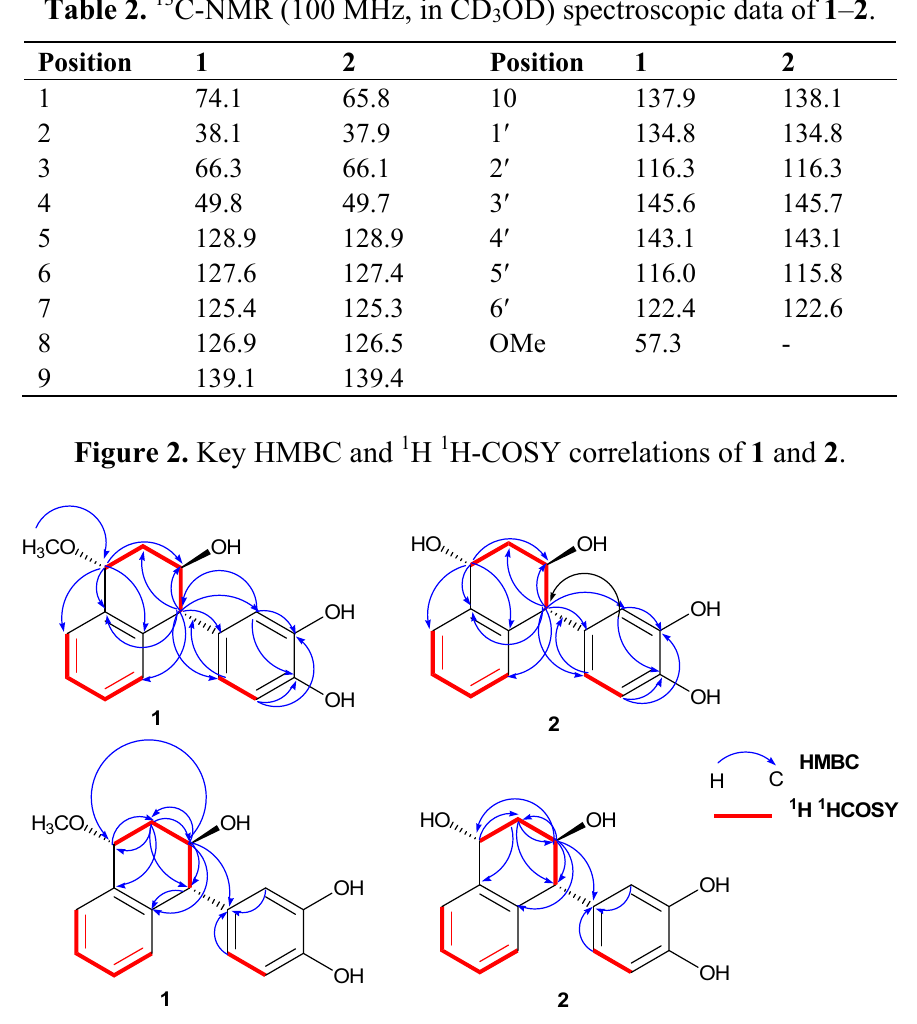
Table 2. 13 C-NMR (100 MHz, in CD